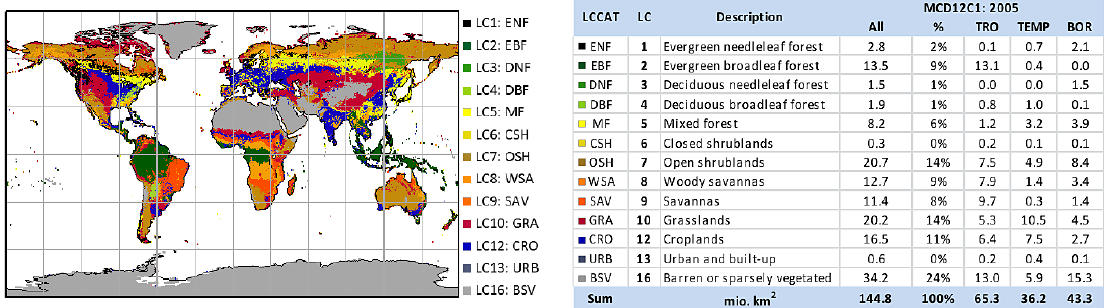
Figure 3. Left: map of MCD12 (v5.1) land cover of the year 2005 (UMD classification) remapped to 0.1 ◦ using largest area fraction approach. Right: area in millions of square kilometres of the UMD land cover classes.